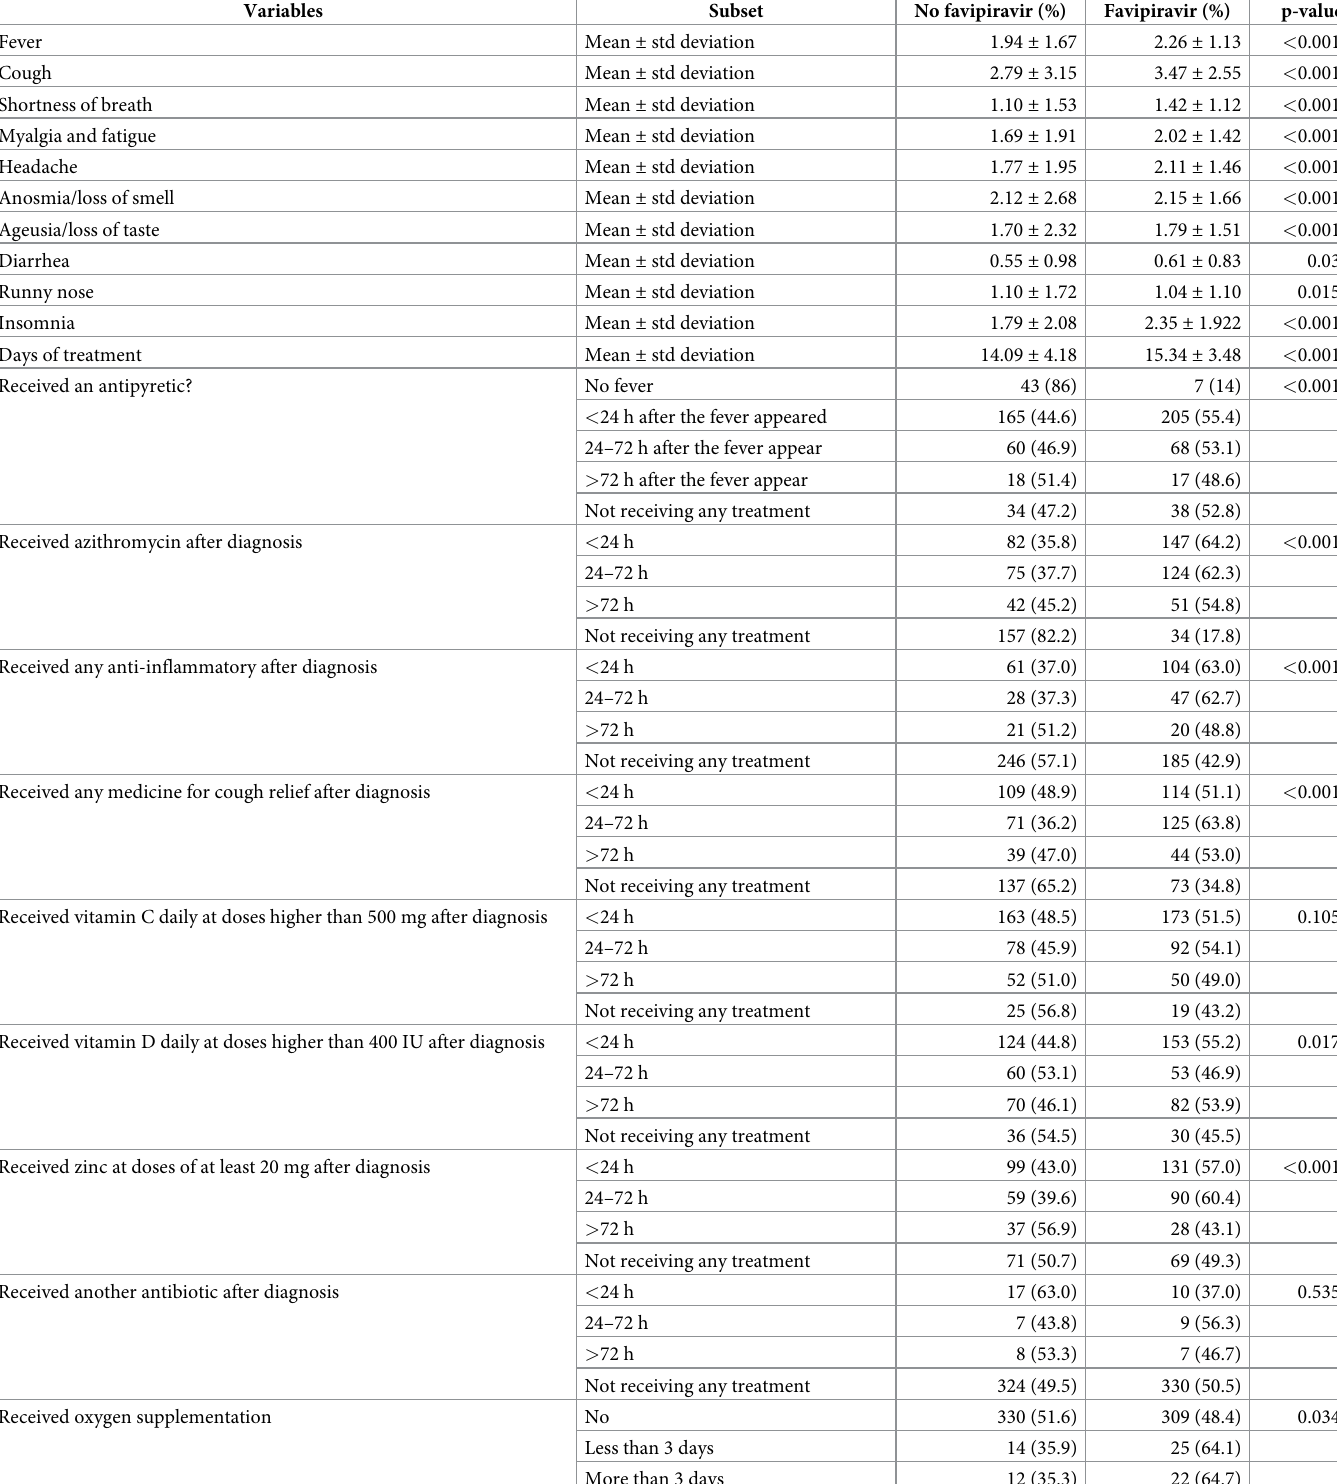
Table 2. Symptoms and treatment received by participants during their COVID